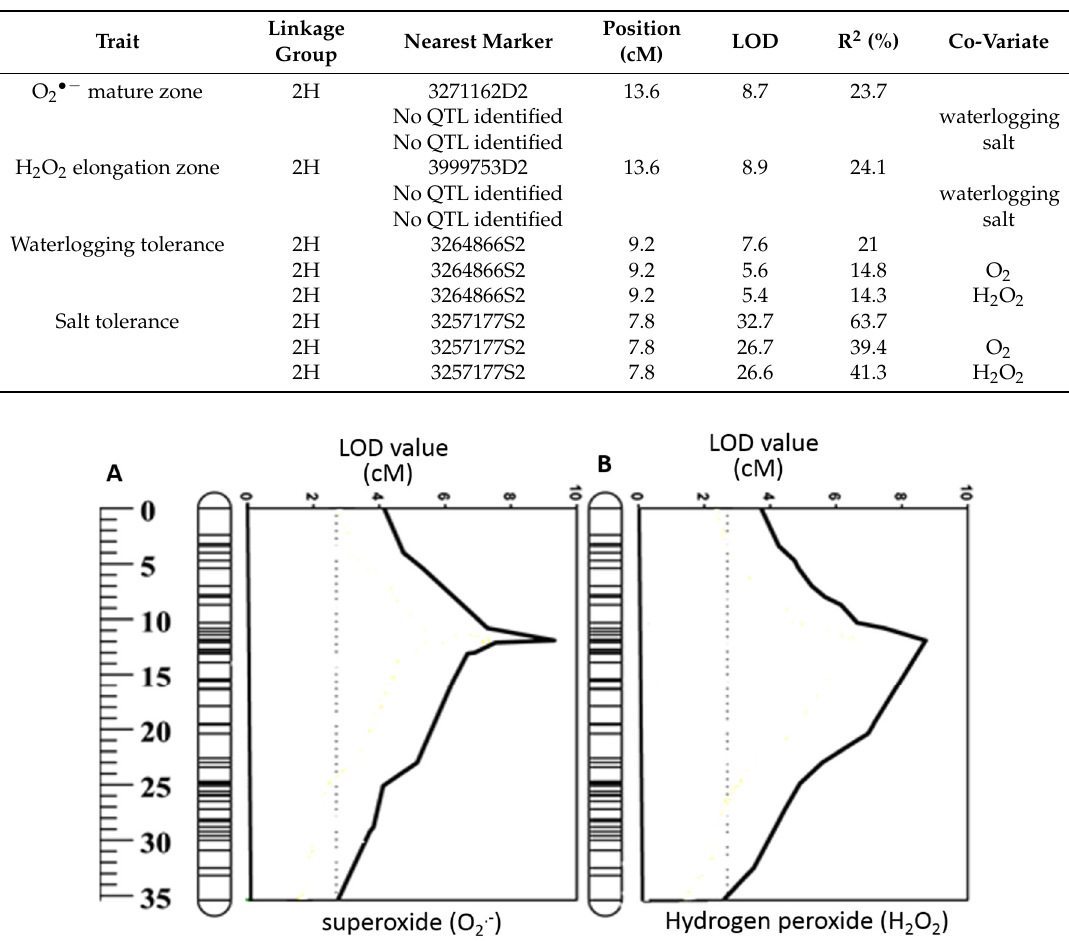
Figure 4. ( A ) QTL associated with superoxide (O 2•− ) radical, and ( B ) hydrogen peroxide (H 2 O 2 ). For the clarity, only parts of chromosome regions are